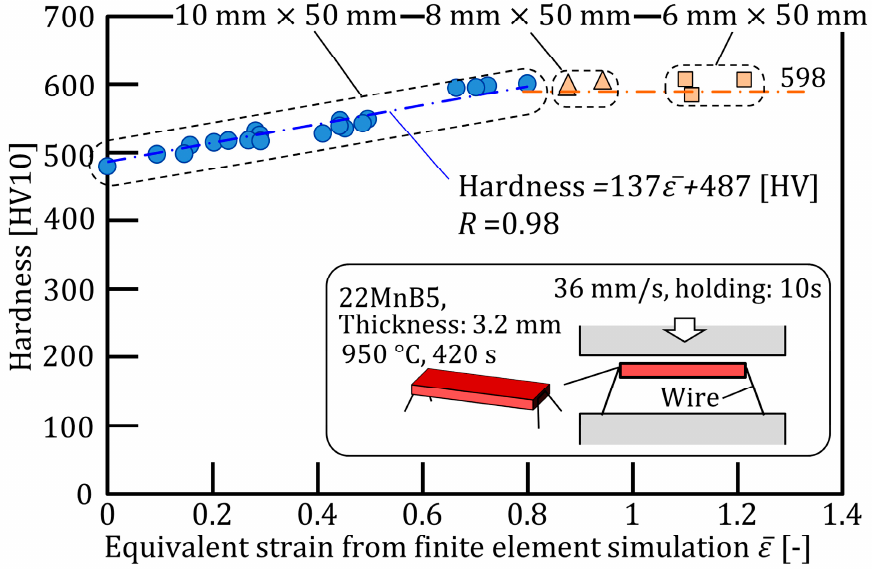
Figure 14. Relationship between Vickers hardness and equivalent strain at centre of cross-section.